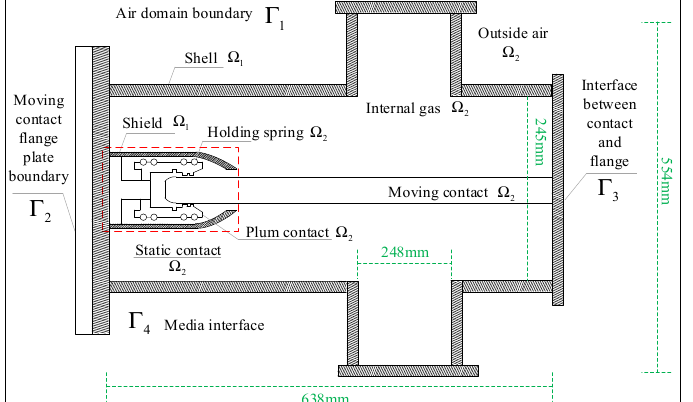
Figure 5. Schematic diagram of the flow field–temperature field solution domain of the GIS isolation switch.